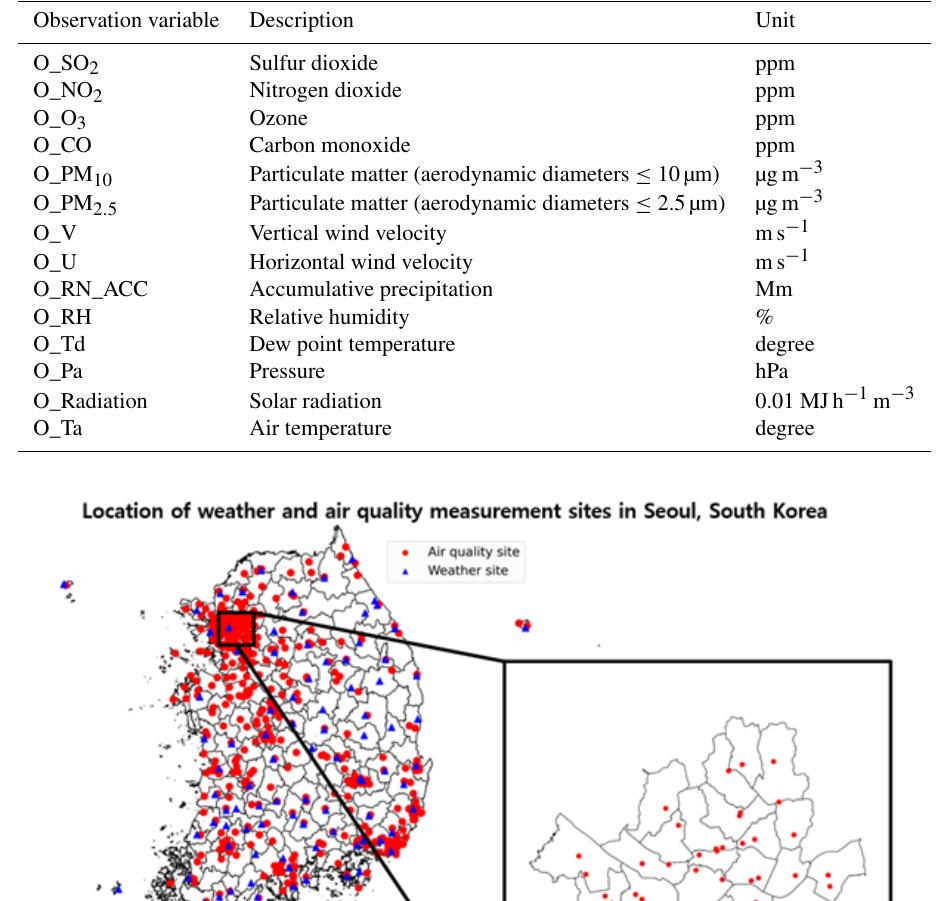
et al., 1999) mechanism was used for the chemical mecha- nism, the fifth-generation CMAQ aerosol module (AERO5; Binkowski et al., 2003) was used for the aerosol mechanism, and the Yamartino scheme for mass-conserving advection (YAMO scheme) (Yamartino, 1993) was used for the advec- tion process. We directly generated the training data using the WRF and